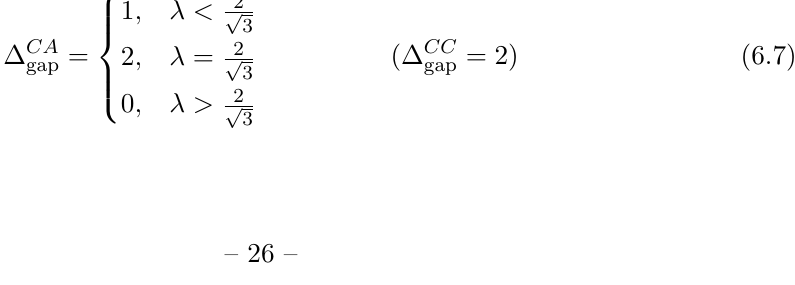
Figure 9. Upper bounds on the gap in the CA channel (cid:1) CA case of c = 9 and q = 1, at derivative orders 8, 12, 16, and 20. The bounding curves are